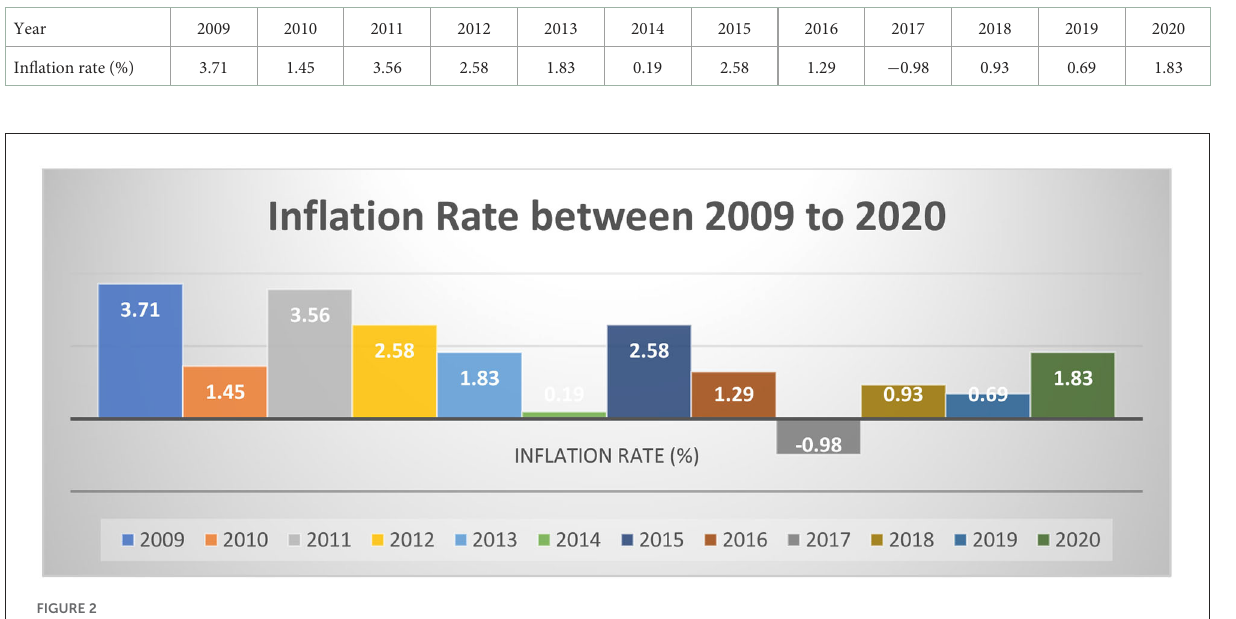
TABLE 5 Inflation rate between 2009 and 2020.